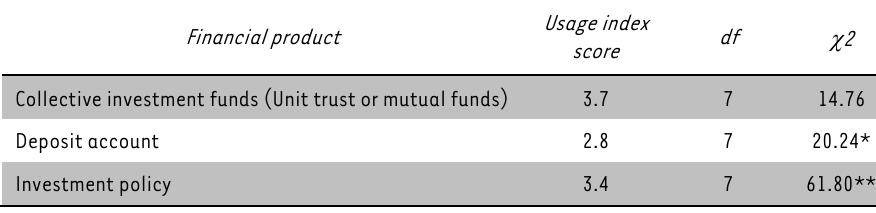
TABLE 5: Basic savings